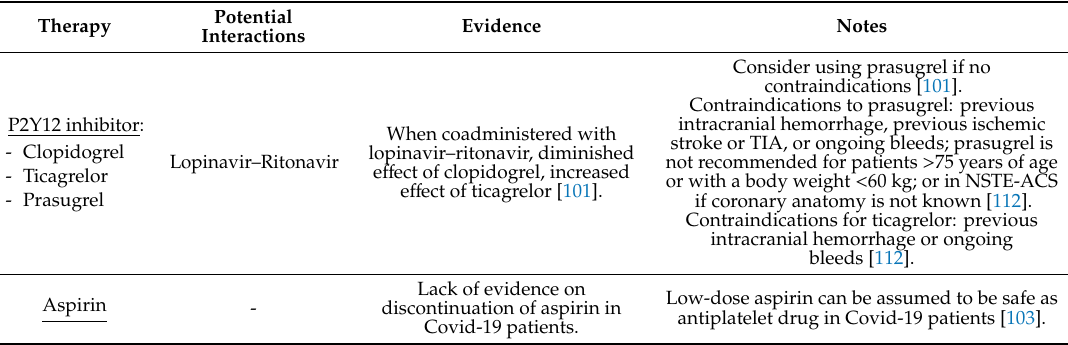
Table 4. Drug treatment of acute coronary syndromes and coronary artery disease—evidence and potential interactions with drugs used to treat SARS-CoV-2